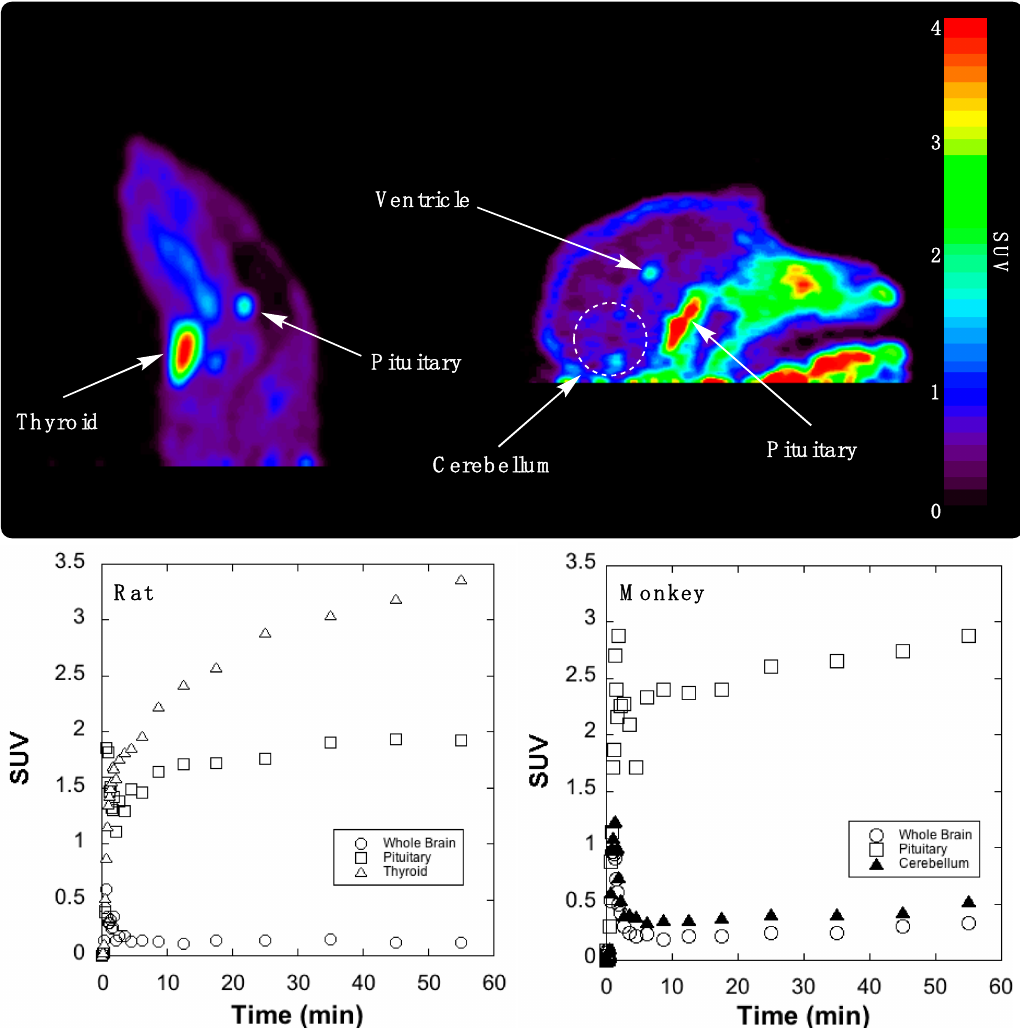
Figure 2. Summed rodent (left) and primate (right) PET images of [ 11 C]AZ683 (0–60 min after injection of the radiotracer) and associated time–radioactivity curves (SUV = standardized uptake value).